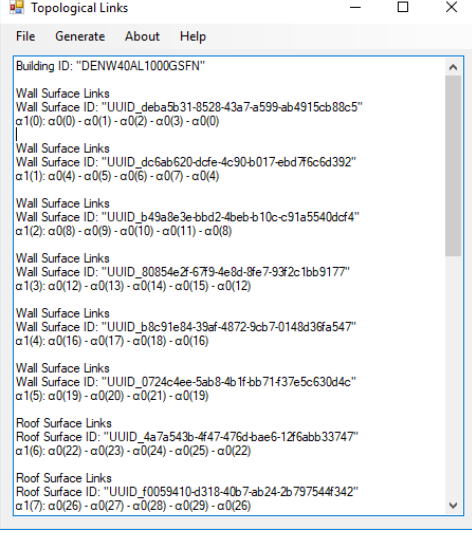
Figure 13. a-1 links for Dataset B The third topological link or a-2 link is generated from the previous a-1 links as input. The a-2 links generated for Dataset A and B are shown in Figure 14 and Figure 15 respectively. A total of 2 a-2 links were generated for Dataset A as a result where each building is represented by one a-2 link. Dataset B also obtained the same amount of a-2 links which is 2 topological